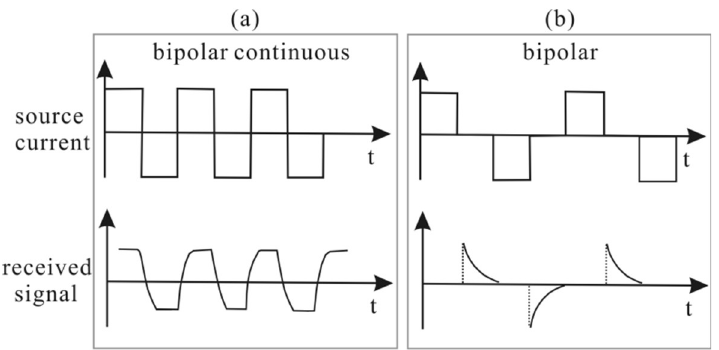
Figure 2. Continuous bipolar and bipolar current forms. ( a ) Bipolar continuous current; ( b ) Bipolar current.